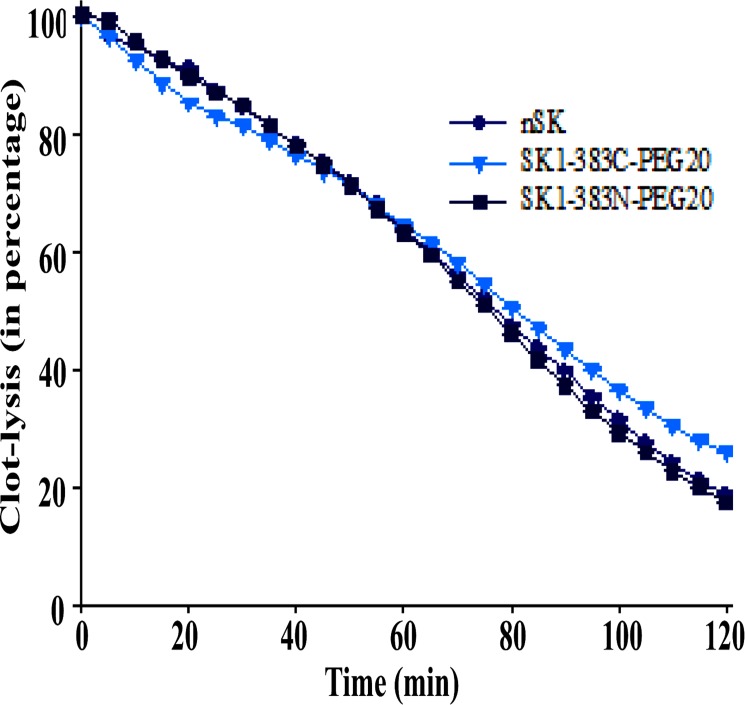
Demonstration of clot-lysis profile of PEG-SK variants in comparison with nSK at 5 nM concentration.A 100 μl of clot was incubated with nSK or its PEGylated derivatives in a microtitre plate at 37°C. Lysis of the clot was measured with time at A405 nm on ELISA plate reader. Graph represents the lysis of clot by SK1-383N-PEG20 (dark blue rectangles) and SK1-383C-PEG20 (blue triangles) in comparison with nSK (black circles). Experiment was performed in triplicates and standard deviation is shown with error bars.